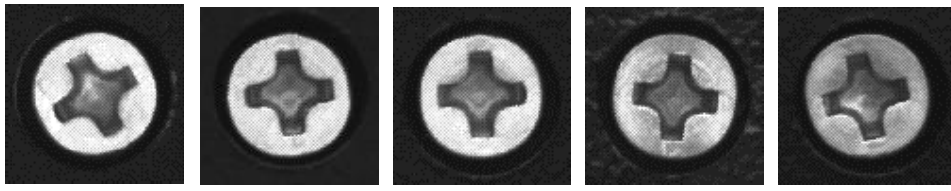
Figure 4. Defect-free screws.